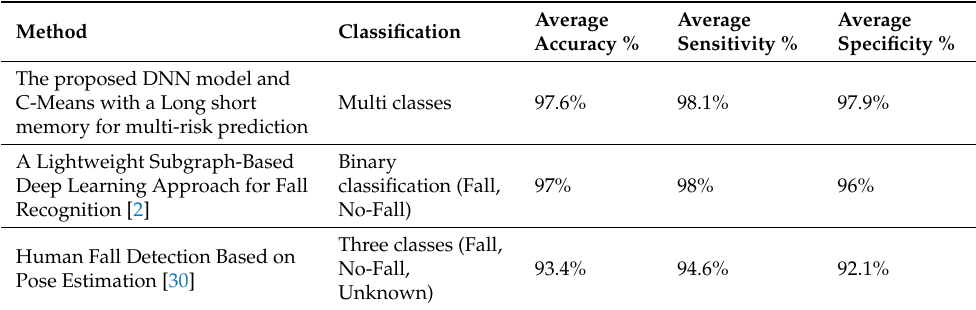
Table 11. Precision comparison averaged on both datasets.